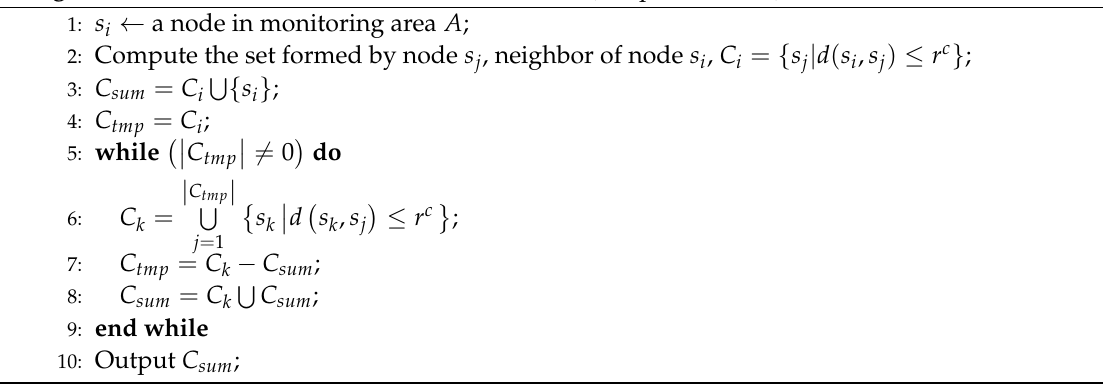
Algorithm 1: Construction of the Information Pool (Output Set C sum ).